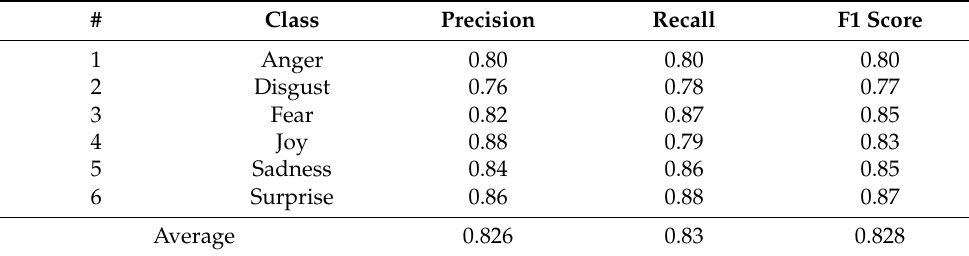
Table 6. Results evaluation.